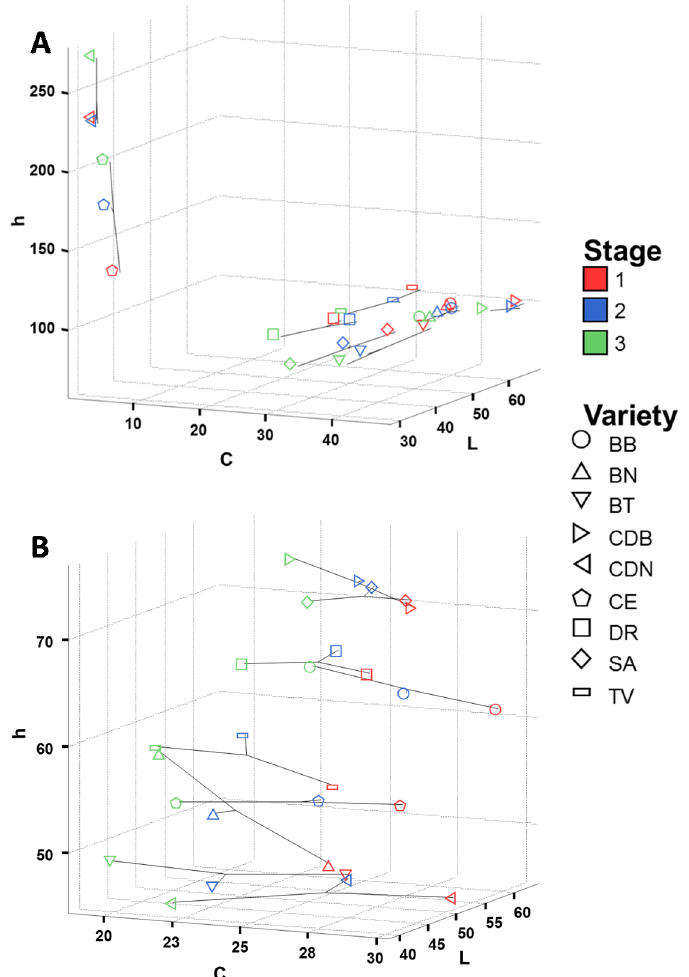
Figure 2. Colour parameters of the fig cultivars at the three ripening stages studied. Skin ( A ); flesh ( B ). L*, Brightness; C*, Chroma and h*, Hue angle.